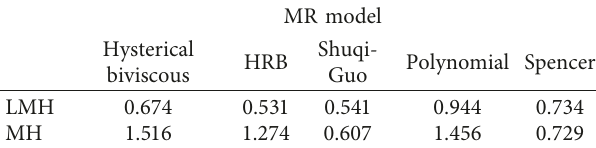
Table 4: Root mean square (rms) value of the sprung mass ac- celeration for simulations with hysteretic models (units in m/s 2